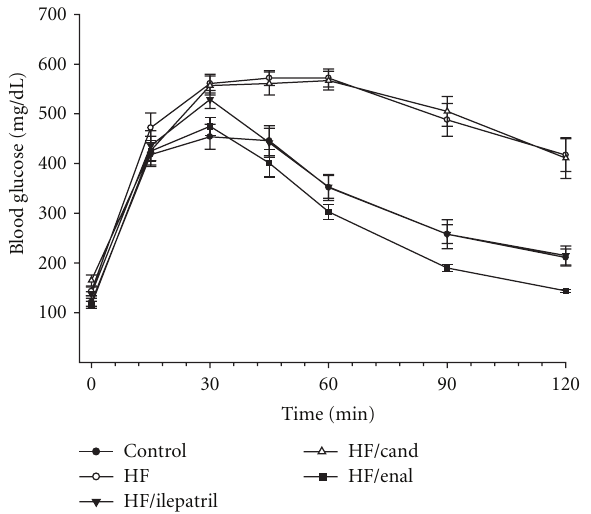
Figure 1: Plasma glucose concentration curve during intraperi- toneal glucose tolerance test (IPGTT) for C57Bl/6J mice fed a normal or high-fat-containing diet with or without ilepatril, can- doxatril, or enalapril for 12 weeks (prevention protocol). Data are the mean ± SEM in mM. Fasting basal blood glucose levels were 121 ± 8, 143 ± 9, 138 ± 4, 175 ± 5, and 116 ± 7 mg/dL for control, high fat, high fat + ilepatril, high fat + candoxatril, and high fat + enalapril, respectively. Control (closed circles), high fat (open circles), high fat + ilepatril (closed innervated triangle), high fat + candoxatril (open triangle), and high fat + enalapril (closed rectangle). The area under the curve (AUC) was significantly di ff erent P < 0 . 01 for high-fat-fed mice versus control and high- fat-fed mice treated with candoxatril versus control. There was no significant di ff erence for AUC between mice fed a high-fat diet containing ilepatril or enalapril versus control. The number of mice in each group was the same as shown in Table 1.